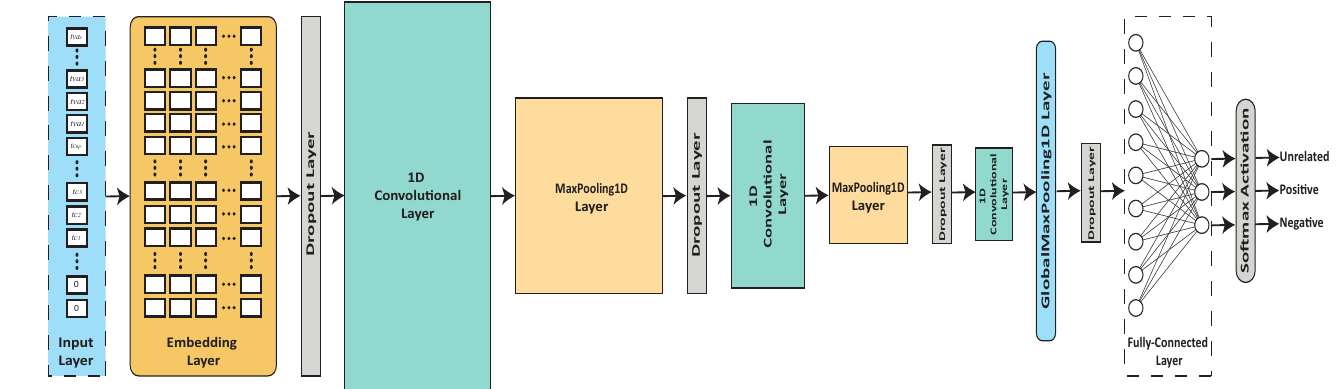
Figure 5. Architecture of the proposed 1D-CNN-based deep learning model.